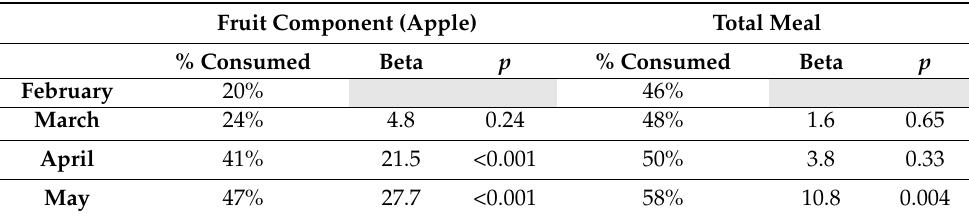
Table 2. Linear regressions for percent consumption of fruit and total meal by month for full sample size, n = 313. Fruit Component (Apple) Total Meal % Consumed Beta p % Consumed Beta